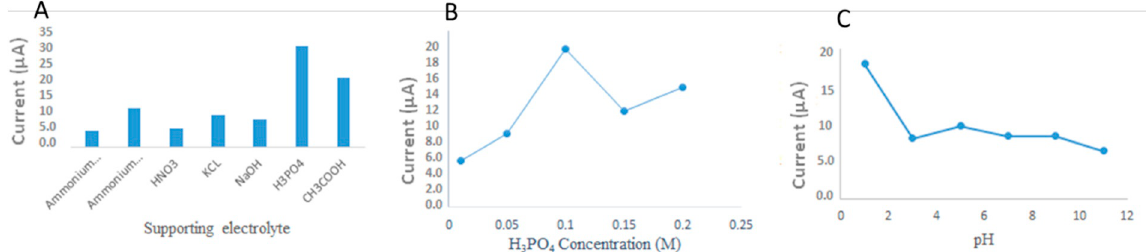
Figure 4. Analytical signals obtained for detection of Rhodamine B: ( A ) different supporting electrolytes, ( B ) different H 3 PO 4 concentrations, and ( C ) pH (1, 3, 5, 7, 9, and 11).